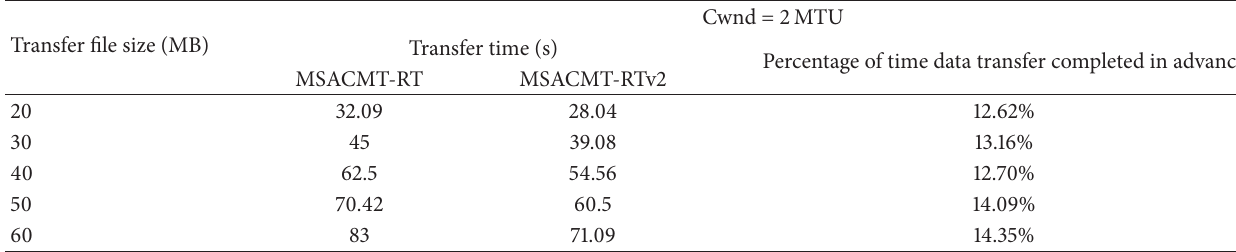
Figure 3: Network simulation topology. Table 1: Time taken for file transfer when rbuf = 128 KB.